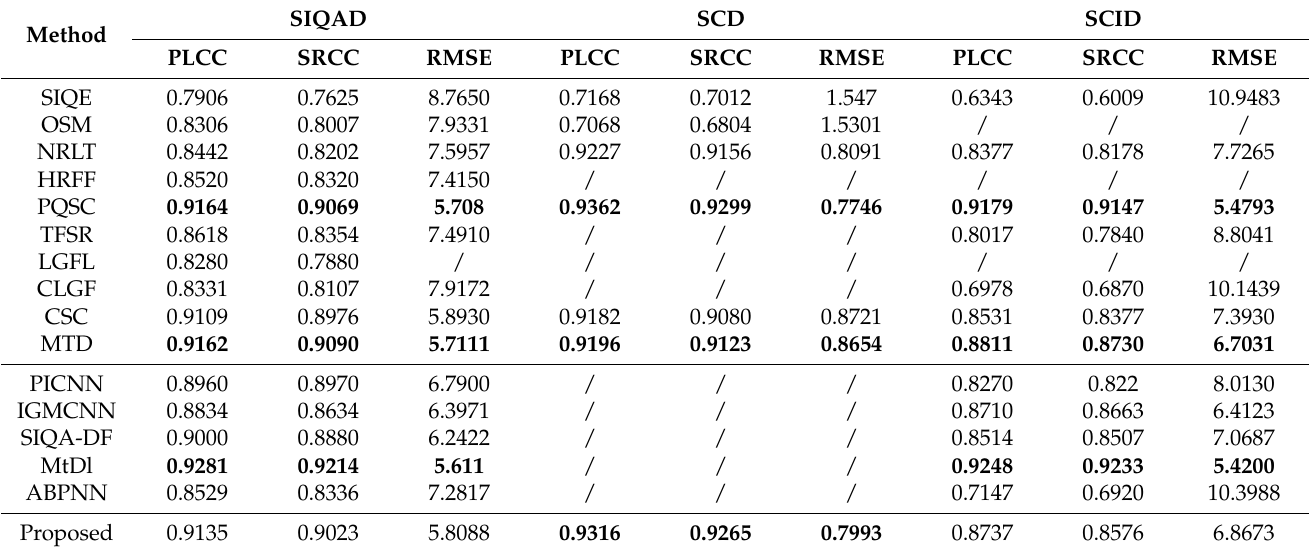
Table 3. Experimental results of the proposed and other NR-IQA methods on SIQAD, SCD, and